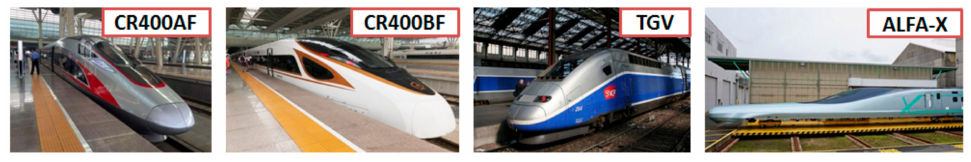
Figure 1. Different types of high-speed trains’ noses.